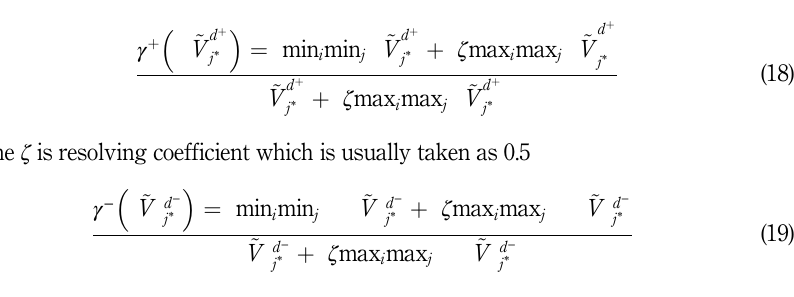
Step 10: Calculation of grey relational grade from grey relational coefficient of individual alternative using Eqn. (20) and